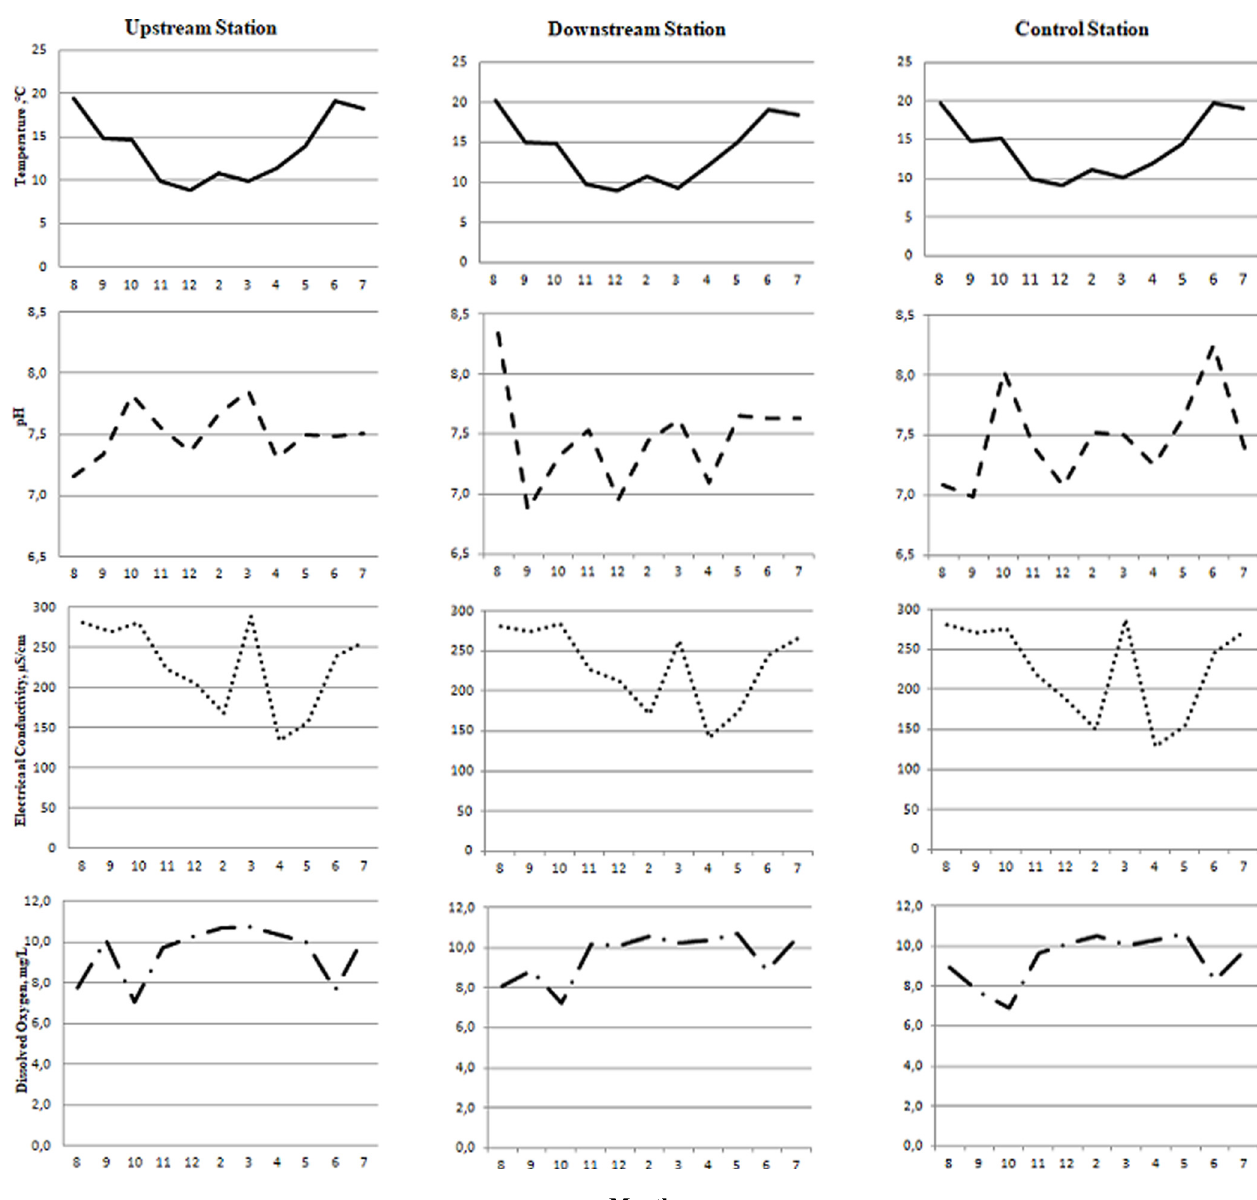
Fig. 4. Physicochemical parameters measured at the three sampling stations on Kocabas Stream near a fi sh farm.